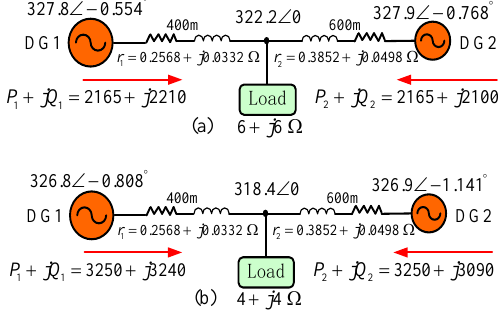
Figure 13. Simulation parameters and results in Case F: ( a ) during 0–0.7 s and 1.4–2 s; and ( b ) during 0.7–1.4 s.